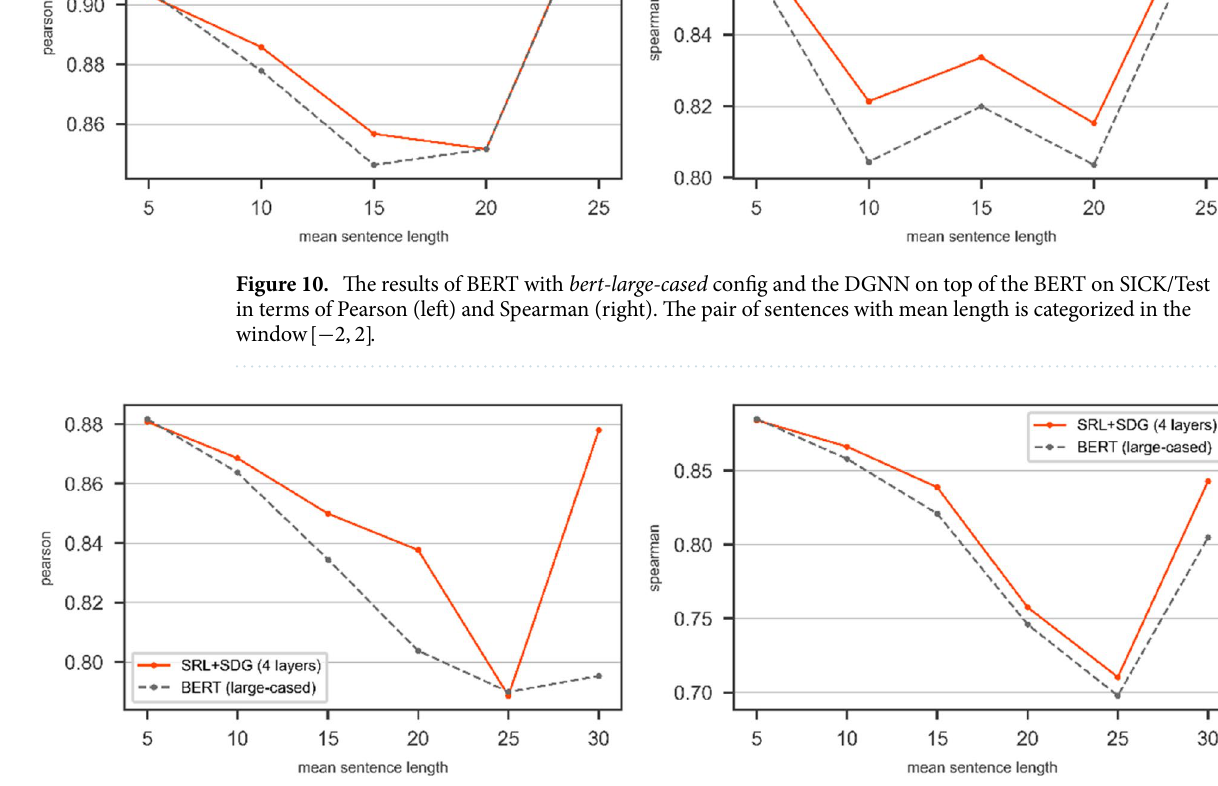
Figure 11. The results of BERT with bert‑large‑cased config and the DGNN on top of the BERT on STS2017/ Test in terms of Pearson (left) and Spearman (right). The pair of sentences with mean length is categorized in the window [ − 2, 2] .